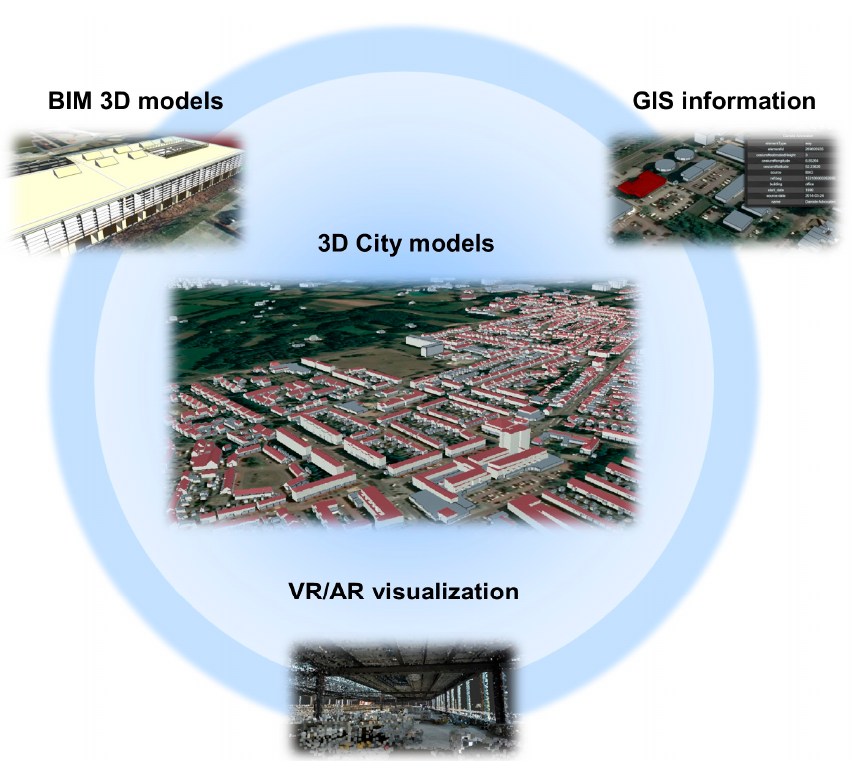
Figure 1. The relationship between 3D city models, BIM, GIS, and VR/AR technologies. Source: author.